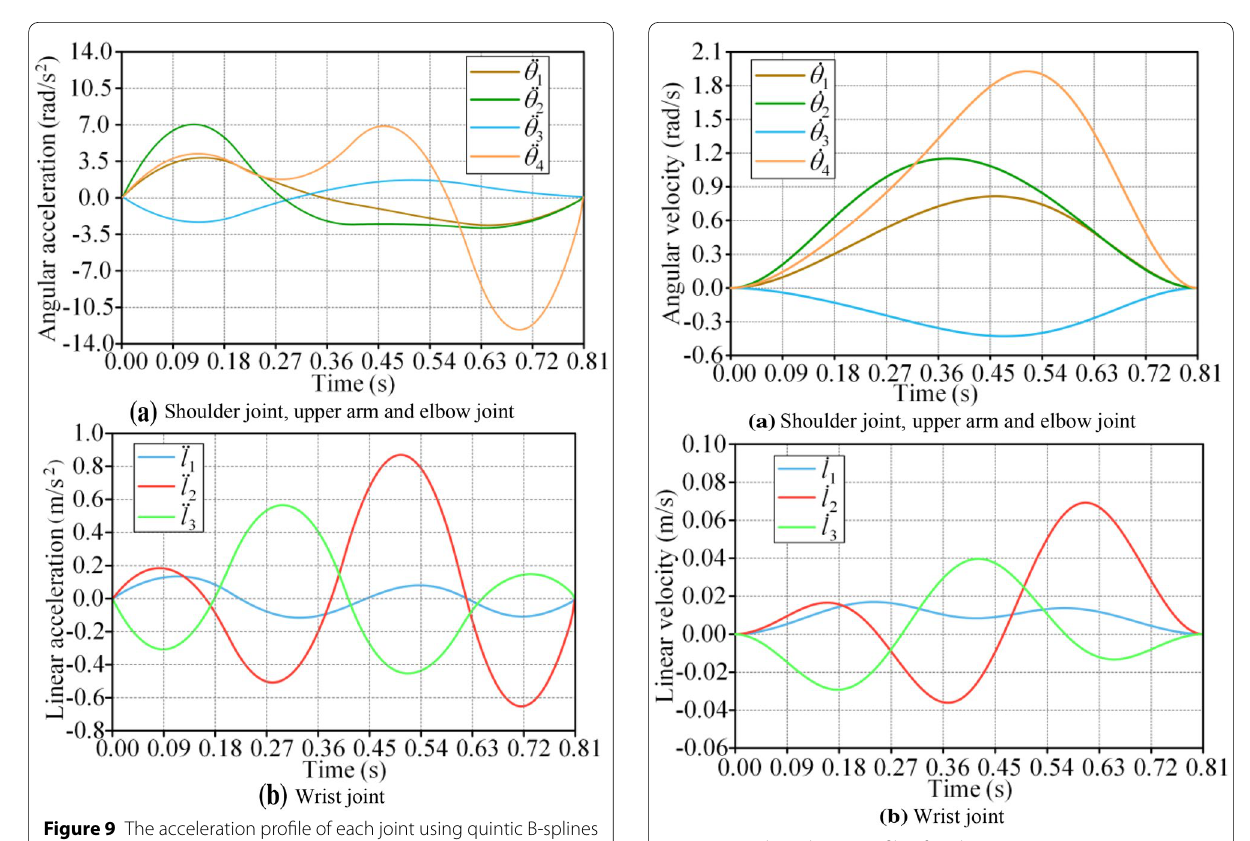
Figure 10 The velocity profile of each joint using composite